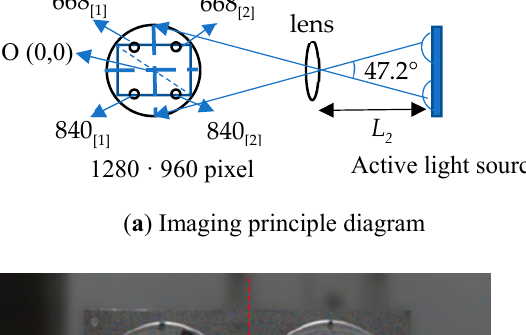
Table 6. According to the pixel coordinates, the radiation intensity can be expressed by the pixel coordinates of four light sources in the image.